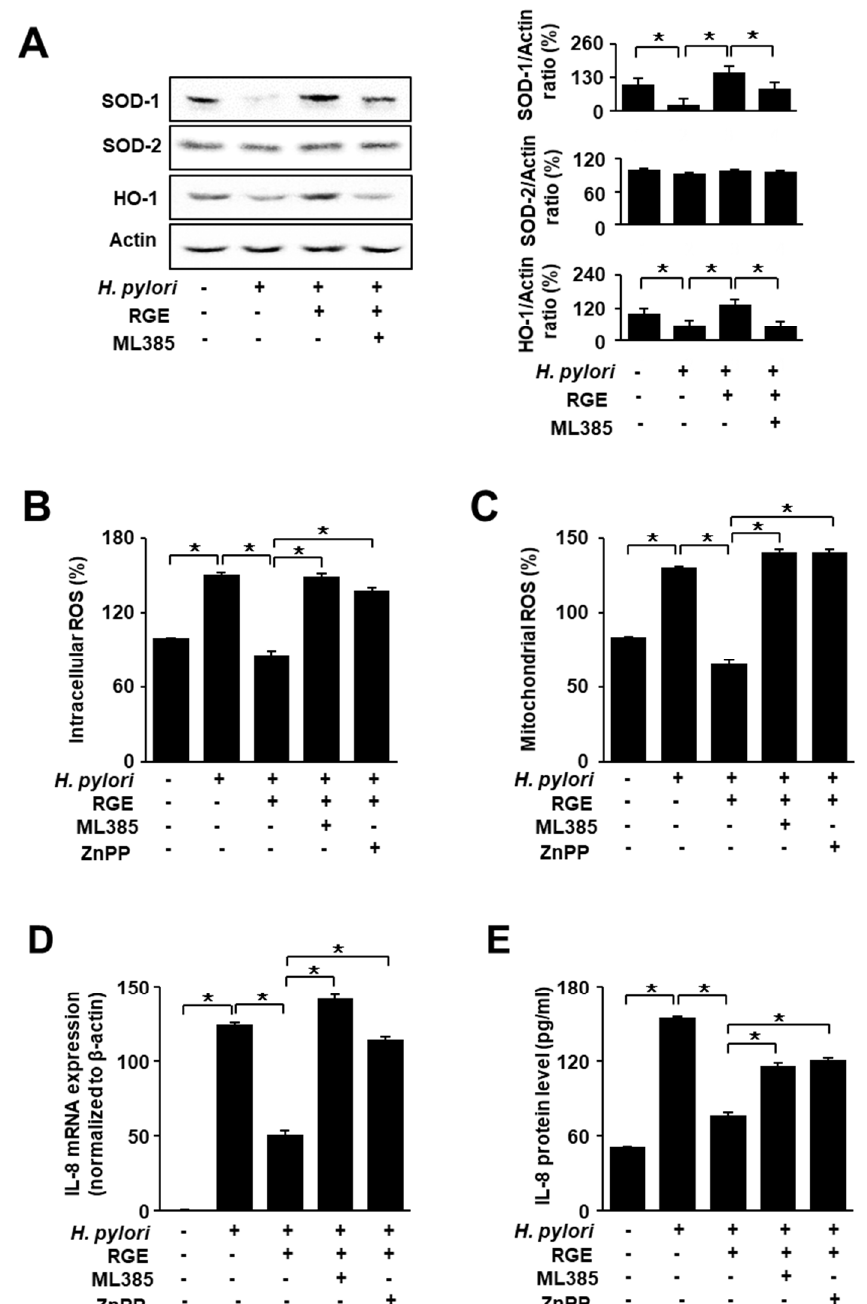
Figure 5. ML385 and ZnPP reverse the effect of RGE on the levels of SOD, HO-1, ROS, and IL-8 in H. pylori -stimulated AGS cells. The cells were co-treated with 1 μ g/mL RGE and 2 μ M ZnPP or 5 μ M ML385 for 1 h, and then infected with H. pylori for 1 h ( A – C ), 4 h ( D ), or 24 h ( E ). ( A ) The levels of HO-1, SOD-1, and SOD-2 were determined by western blotting (left panel). The ratios of SOD-1/Actin, SOD-2/Actin, and HO-1/Actin were determined from band densities of these proteins. Control (cells without any treatment or stimulation) was set at 100. * p < 0.05 (right panel). ( B ) The level of intracellular ROS was measured by dichlorofluorescein diacetate analysis. The intracellular ROS level in the untreated and uninfected cells was set at 100%. ( C ) Mitochondrial ROS was measured using MitoSOX. The mitochondrial ROS level in the untreated and uninfected cells was set at 100%. ( D ) IL-8 mRNA expression was quantified using real-time polymerase chain reaction (PCR) and normalized to β -actin. ( E ) IL-8 levels in the culture medium were assessed by enzyme- linked immunosorbent assay (ELISA). * p < 0.05.